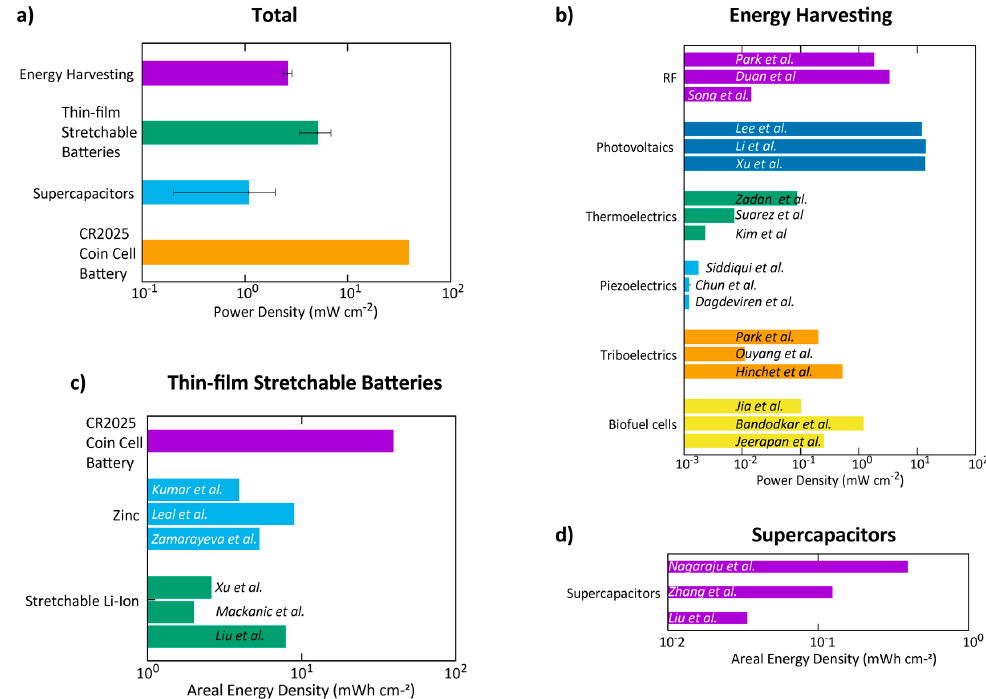
Figure 6. Energy storage and harvesting through thin-film or printed systems. ( a ) all the averaged energy options compared to a coin-zed battery. ( b ) Energy harvesting radio-frequency (RF): Park et al. [121], Duan et al. [122] and Song et al. [123]. Photovoltaics: Lee et al. [124], Li et al. [125] and Xu et al. [126]. Thermoelectric: Zadan et al. [127], Suarez et al. [128] and Kim et al. [129]. Piezoelectric: Siddiqui et al. [130], Chun et al. [131] and Dagdeviren et al. [132]. Triboelectric: Park et al. [133], Ouyang et al. [134]